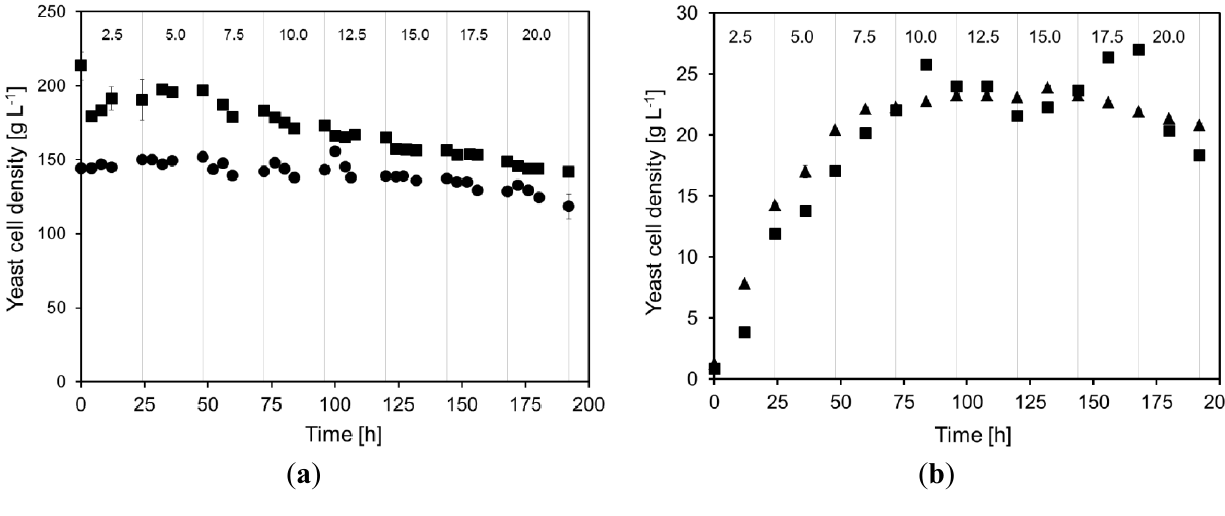
Figure 1. Yeast cells density in the MBR during two separate cultivations A ( ■ ) and B ( ▲ ), at very high ( a ) and high ( b ) yeast concentration. The total acetic acid concentration in the feed medium was changed every 24 h (vertical lines). The numbers at the top of the figure denote the approximate acetic acid concentration in the medium (in g·L − 1 ) during each such 24 h period. The error bars in the graphs denote the maximum and minimum results for duplicate dry weight